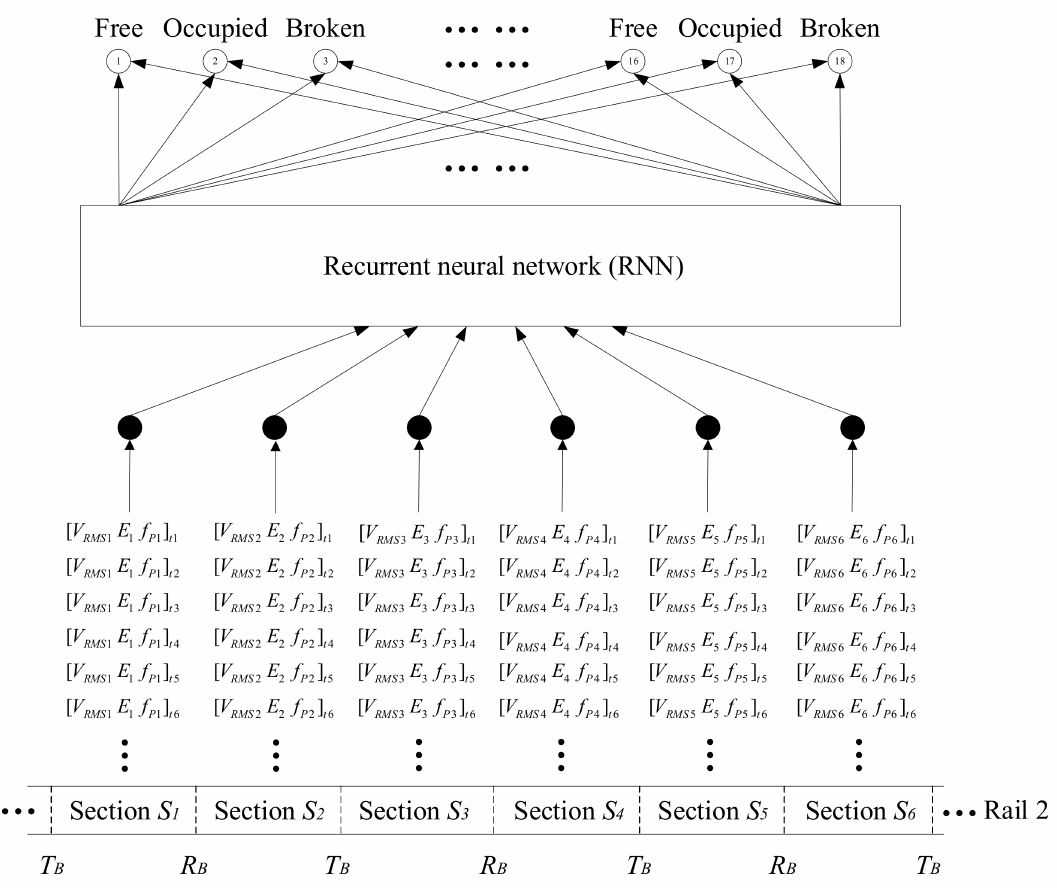
Figure 25. Preliminary approach for the track section status classification